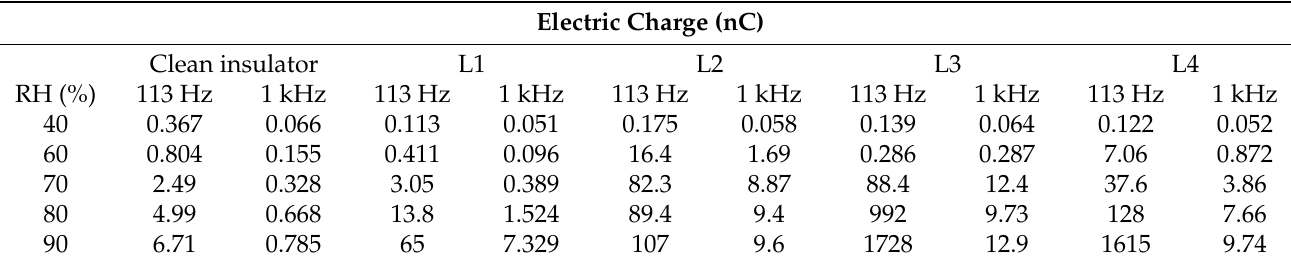
Table 3. Electric charge evaluated data at frequencies 113 Hz and 1 kHz.